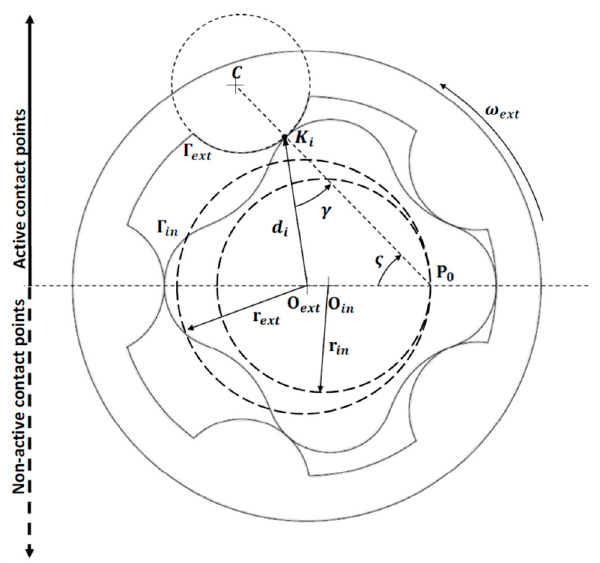
Figure 5. Geometrical quantities for contact force evaluation.